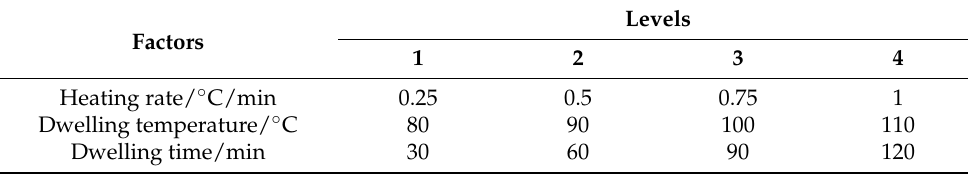
Table 2. Heating rate, dwelling temperature, and dwelling time of the